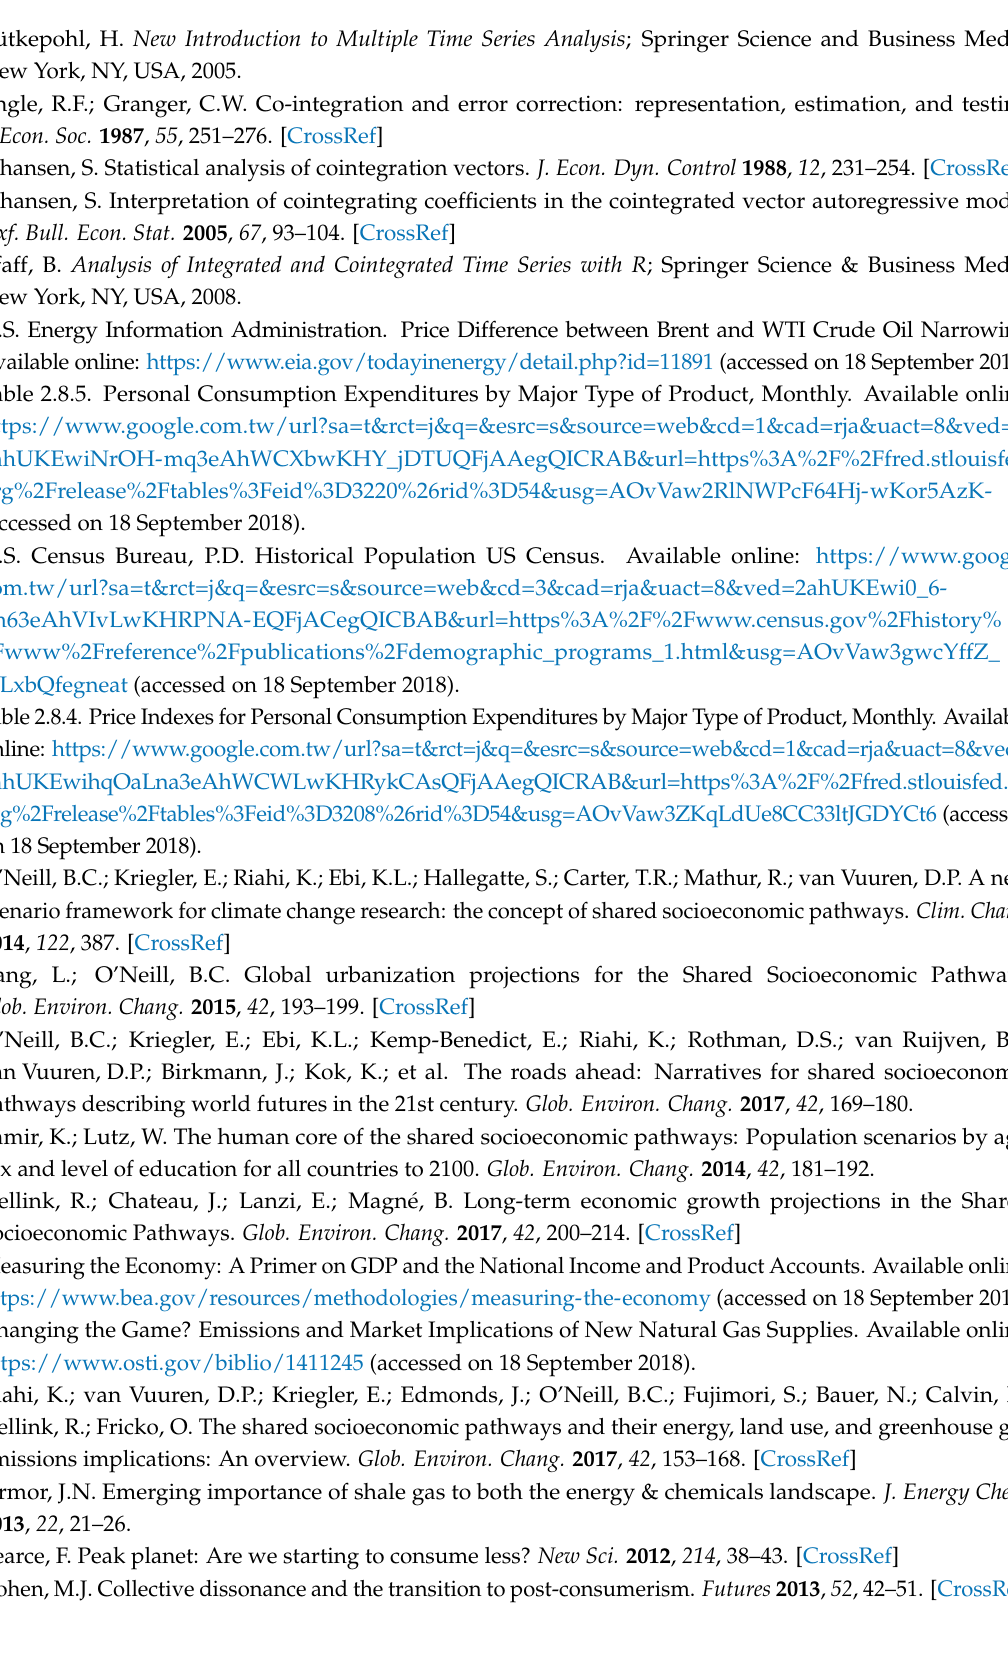
Table 2.8.5. Personal Consumption Expenditures by Major Type of Product, Monthly. Available online: